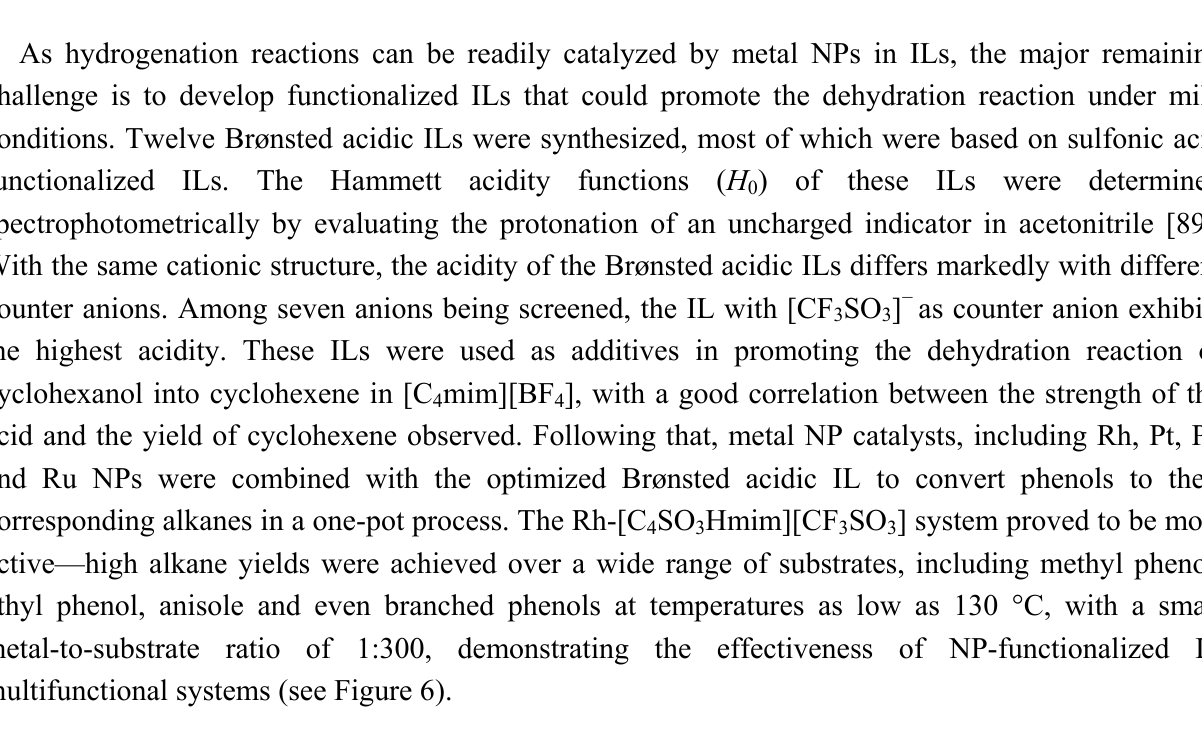
Figure 6. Graphic illustration of acid-NP multifunctional system for the upgrading of phenolic compounds into alkanes. Reprinted from Ref. [85], with permission from